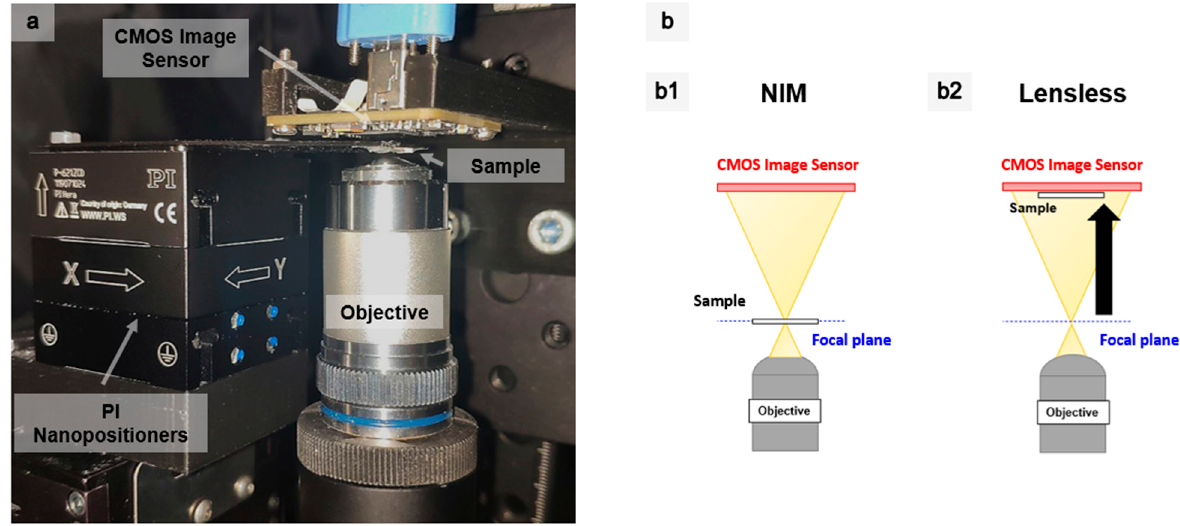
Figure 2. ( a ) Setup of the scanning transmission optical microscope with optical downscaling. ( b ) Schematic diagrams of the STOM with optical downscaling in different operating modes. ( b1 ) NIM mode. ( b2 ) Lensless mode.